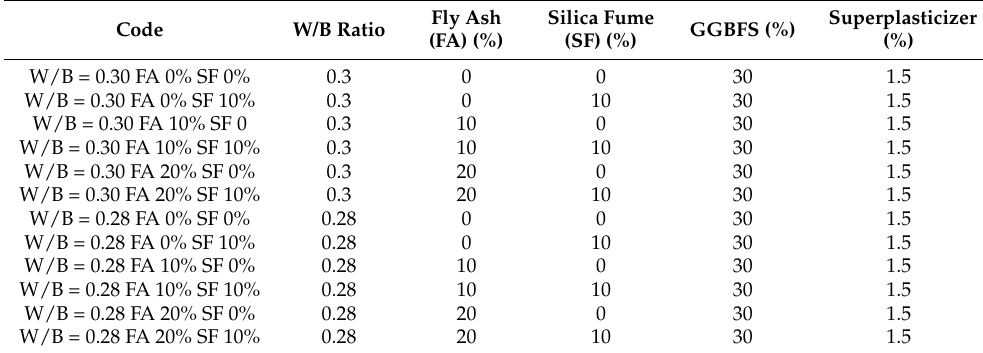
Table 1. The mixture proportions of the 12 types of concrete samples.